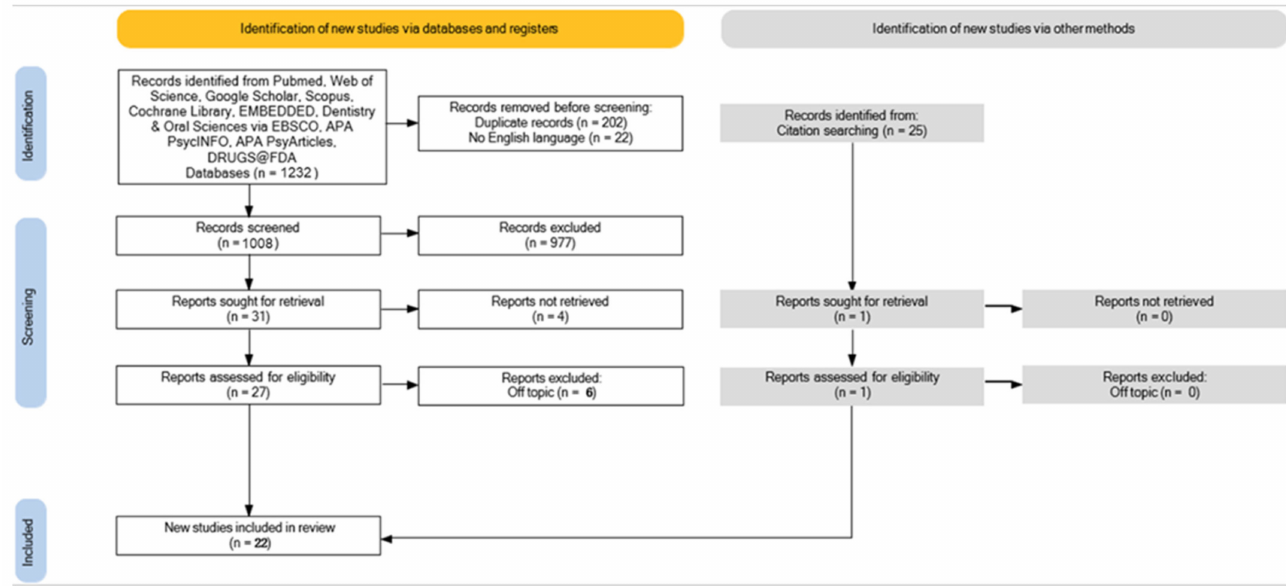
Figure 3. PRISMA flowchart diagram of the inclusion